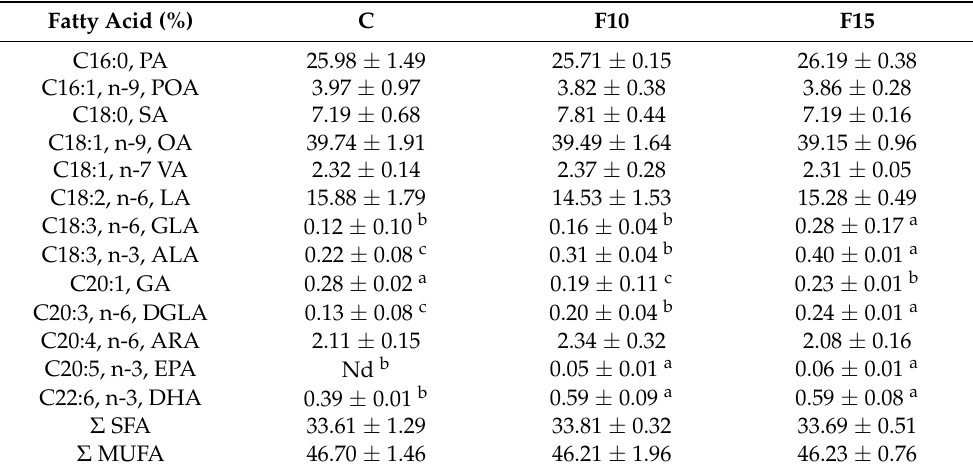
Table 4. Fatty acid profile of eggs produced in the 31st week of laying (%). Means with different superscripts are significantly different ab p < 0.05.